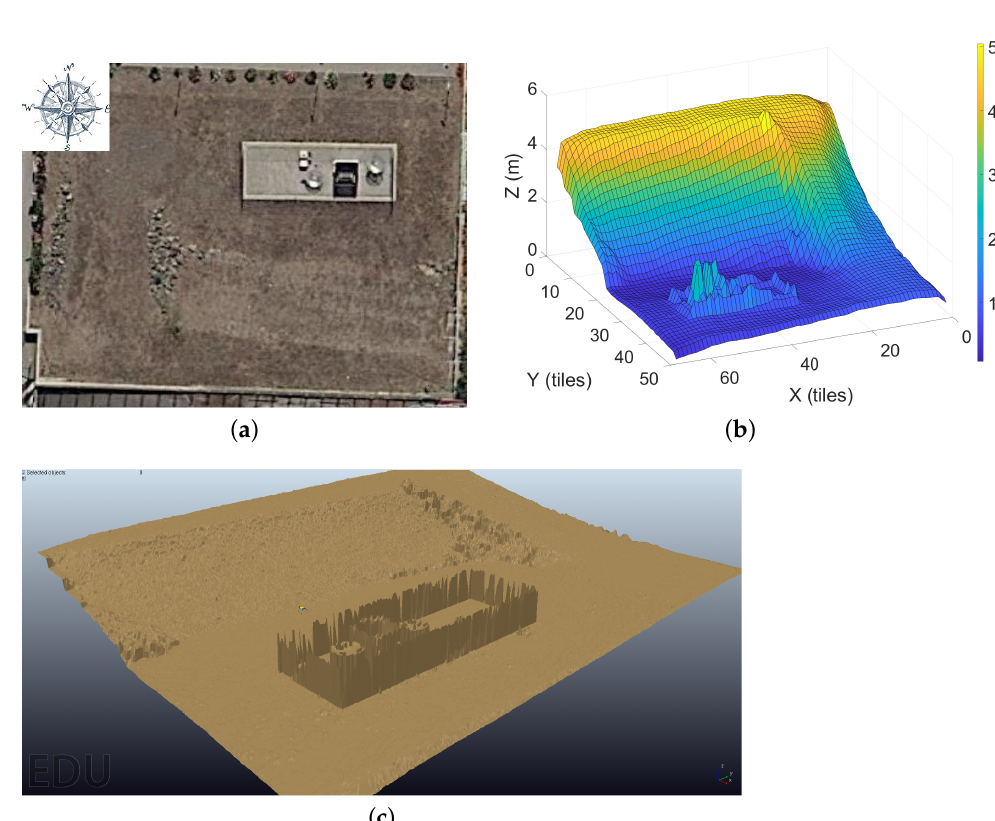
Figure 5. Terrain adopted for the simulations. ( a ) Aerial image; ( b ) 3D terrain reconstruction; ( c ) terrain reconstructed in the dynamic simulation environment.